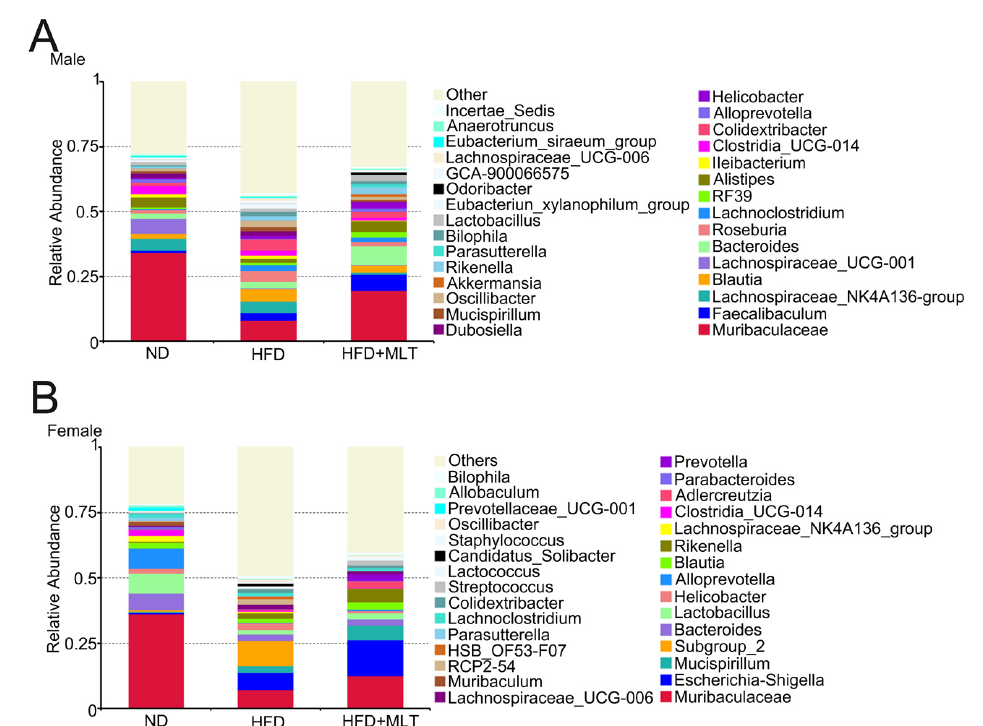
Figure 6. MLT treatment restores the changes in gut microbiota abundance caused by an HFD. A community analysis of the three groups was conducted by analyzing the relative abundance of intestinal bacterial flora at the genus level in mice. In the HFD group, the relative abundance of Blautia increased in male mice ( A ), while the relative abundance of Lactobacillus decreased significantly in female mice ( B ). (MLT, melatonin; HFD, high-fat diet).